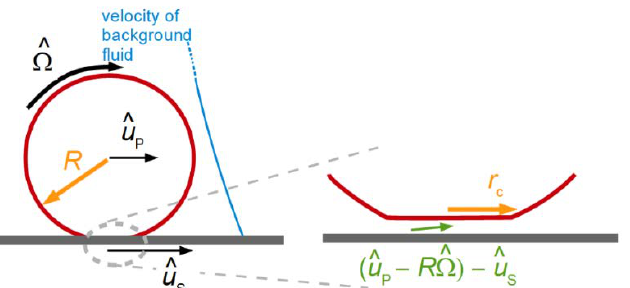
Figure 34. The sphere undergoes both translation and rotation. The transverse force at the contact is proportional to the displacement at the contact, which is different from the displacement of the sphere center.